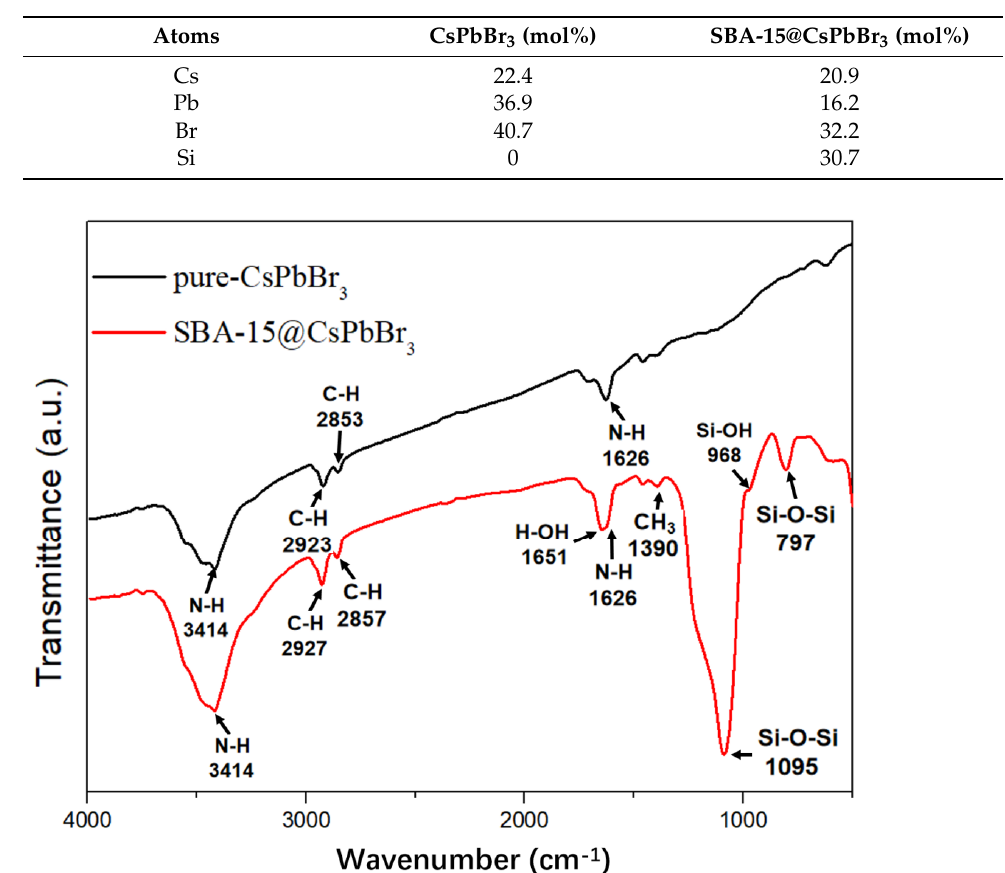
Table 1. The elemental mole fraction of CsPbBr 3 QDs and SBA-15@CsPbBr 3 QDs.